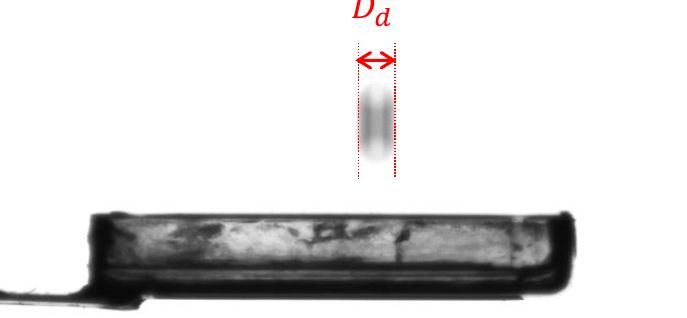
Figure 14. Footage of the experimental test of a drop impacting on a dry spoon. D d drop